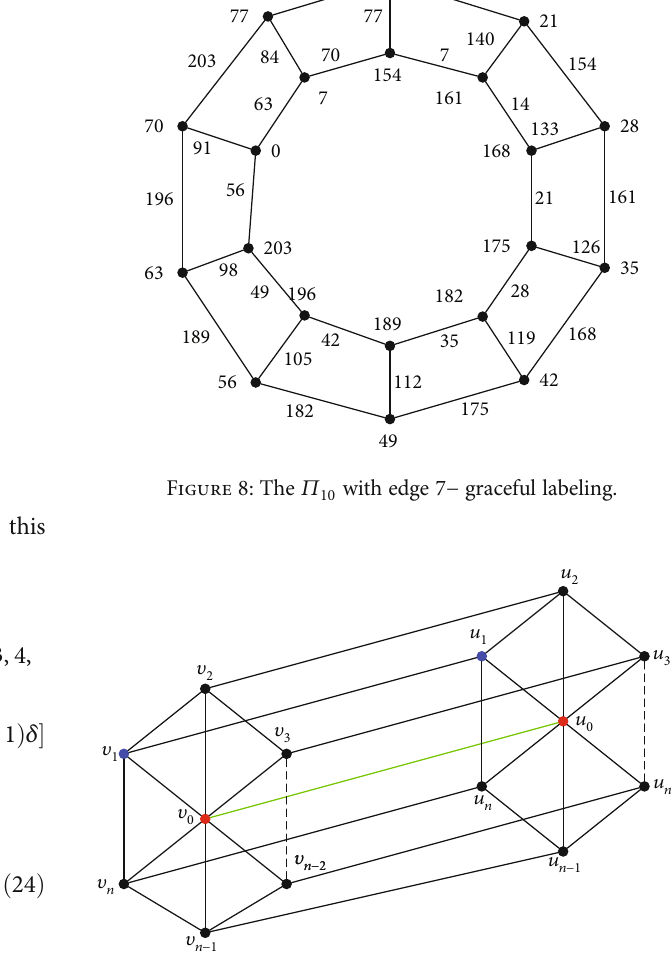
− graceful labeling. 10,10 with edge 5